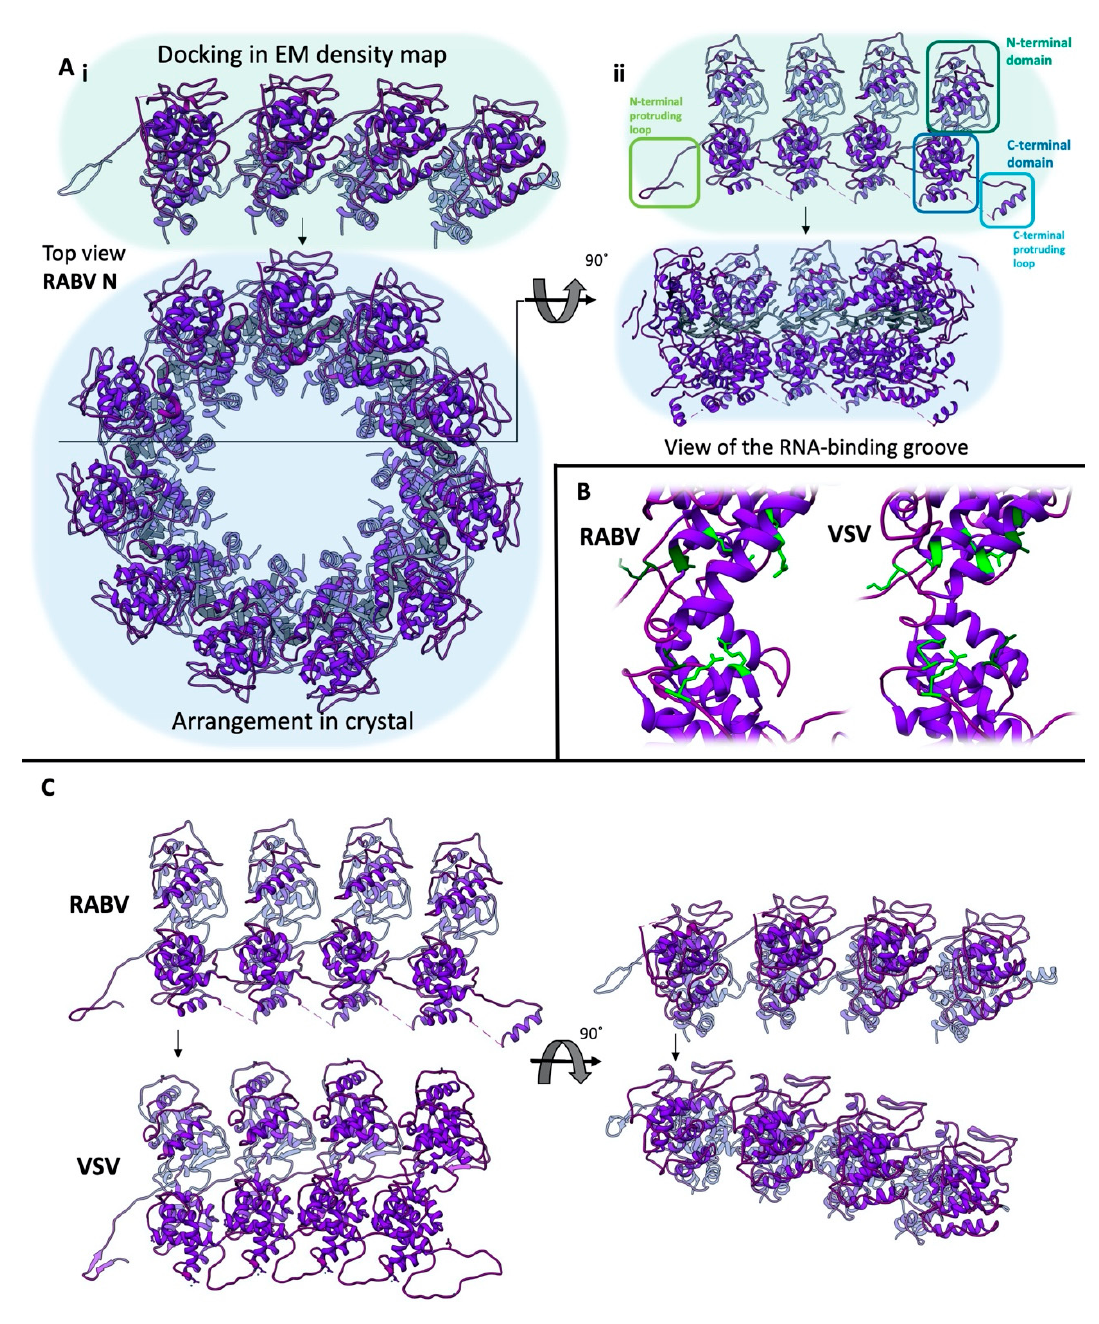
Figure 2. Comparison of the RABV and VSV N-protein structures (pdb 2gtt (RABV, [9]) and 2gic (VSV, [8])). ( A ) Comparison between the arrangement of the RABV N-protein in the crystal and docked in the cryo-electron density map from the top ( i , view on the N-terminal domain) or the RNA binding groove ( ii ). Panels i and ii are not at the same scale. ( B ) Comparison of the residues interacting with the phosphate backbone (light green) of the viral genome between RABV and VSV. Positively charged residues that do not interact with the phosphate backbone but protrude into the RNA binding groove are depicted in dark green. ( C ) Comparison of the arrangement of N-proteins when docked into the CryoEM reconstructions of the RABV and VSV ribonucleoprotein complex (RNP). The N-monomers used for alignment of the different N-protein arrangements are connected using black arrows. EM: electron microscopy.